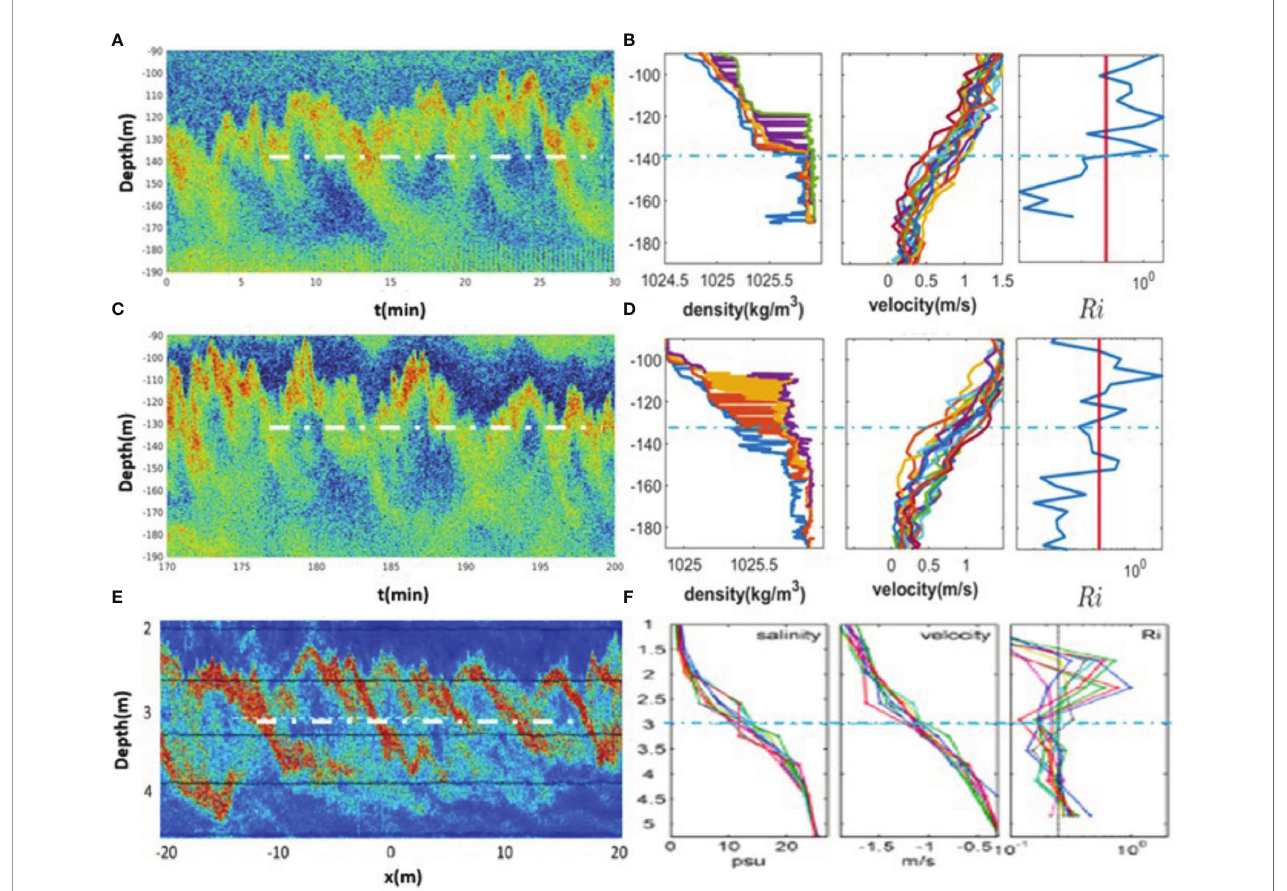
FIGURE 6 | (A, C) The observed echo sounder intensity, (B, D) density pro fi les, velocity pro fi les, and the gradient Richardson number (red solid lines indicate Ri g =0.25) in the lee of a topographic ridge near the Green Island along the route of the Kuroshio. Observations were taken between (A) 03/22/2012 06:22:23- 06:52:23AM and (C) between 03/22/2012 09:13:43-09:43:43AM. In the x axis t=0 is set as 03/22/2012 06:22:23. The white/blue dash lines separate the cusp-like band and the core of shear instabilities (indicated by white circles in Figure 5A ) with Ri g <0.25. (E) The observed echo sounder intensity, (F) salinity pro fi les, velocity pro fi les, and the gradient Richardson number in the Connecticut River, USA. The fi gure is adopted from Geyer et al.